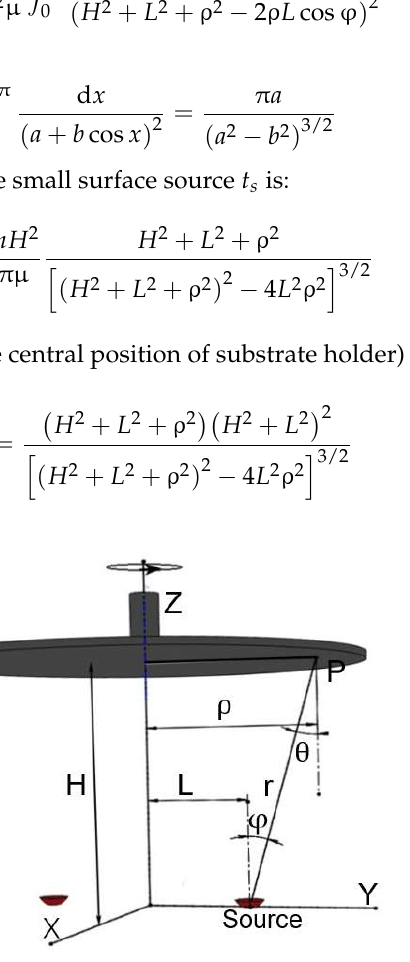
Figure 10. Rotating planar substrate holder, where H is the distance between the source and the substrate holder; ϕ is the angle between the normal of the source and the line connecting the source to the P point; θ is the angle between the normal of the substrate and the line connecting the source to the P point; ρ is the distance from the center of the substrate holder to the P point; r is the distance from the source to the P point; L is the distance from the source to the center; P is any point on the substrate holder.